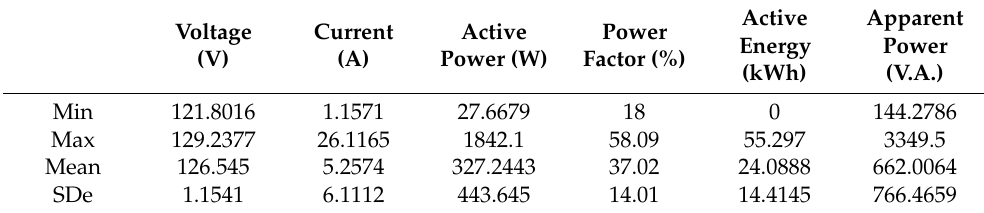
Table 6. Statistical data of the readings made with Sensor 1 of the proposed system during the dates of 23 June and 30 June 2022.